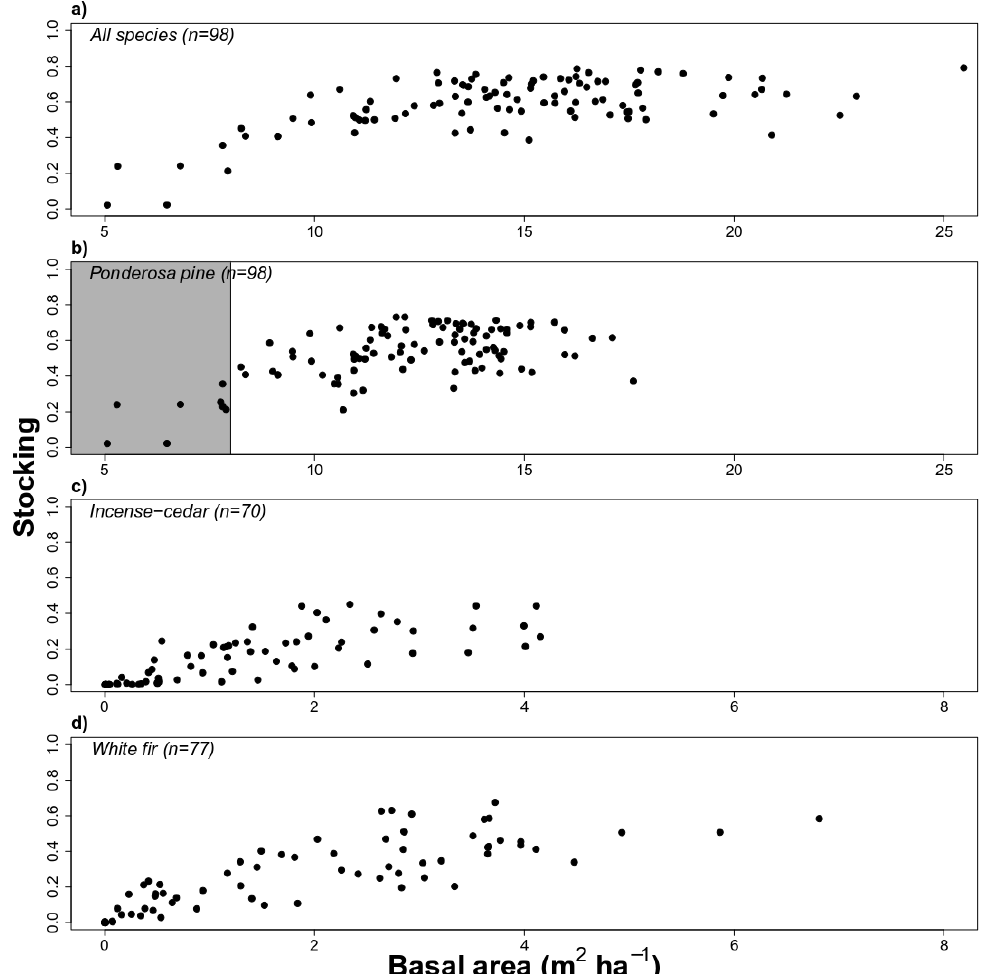
Figure 5. Relationship between overstory basal area per hectare and stocking proportion calculated at 0.0016 ha for 98 compartments in 1935 ( a ). Relationship between stocking proportion by species and corresponding overstory basal area of that species for ( b ) ponderosa pine, ( c ) incense-cedar, and ( d ) white fir. The highlighted grey area represents the range of incense-cedar and white fir overstory basal area compared to ponderosa pine.